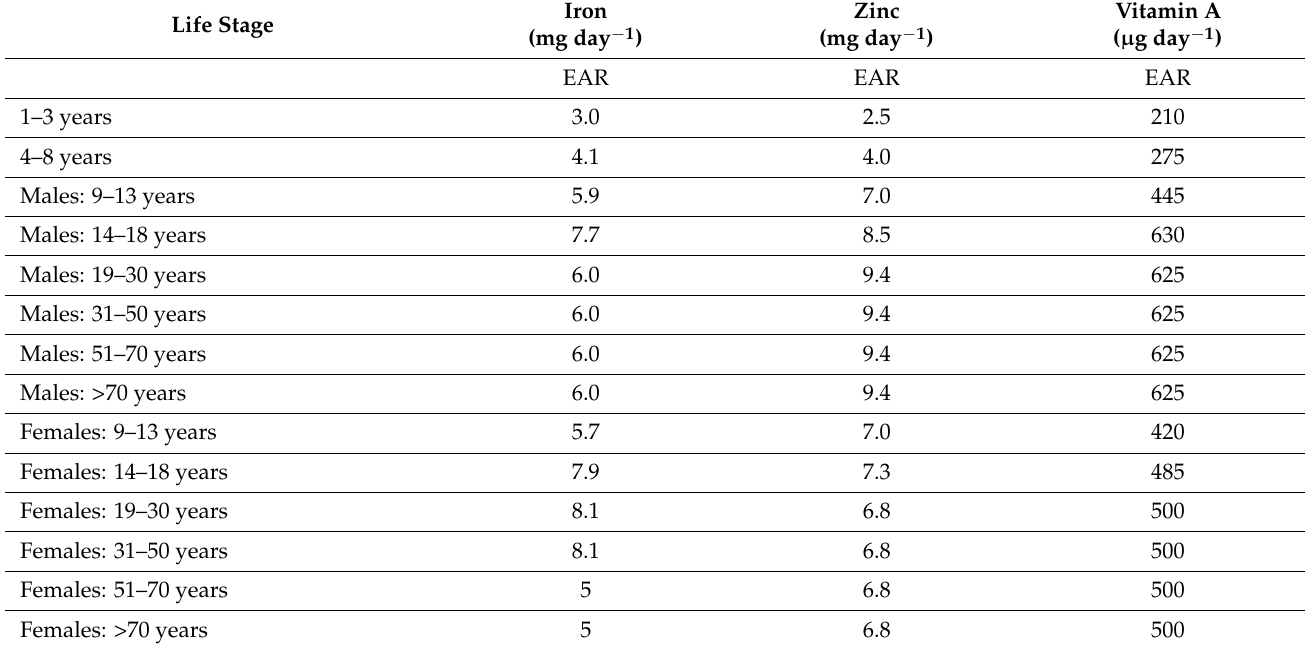
Table 3. Dietary Reference Intakes (IOM,